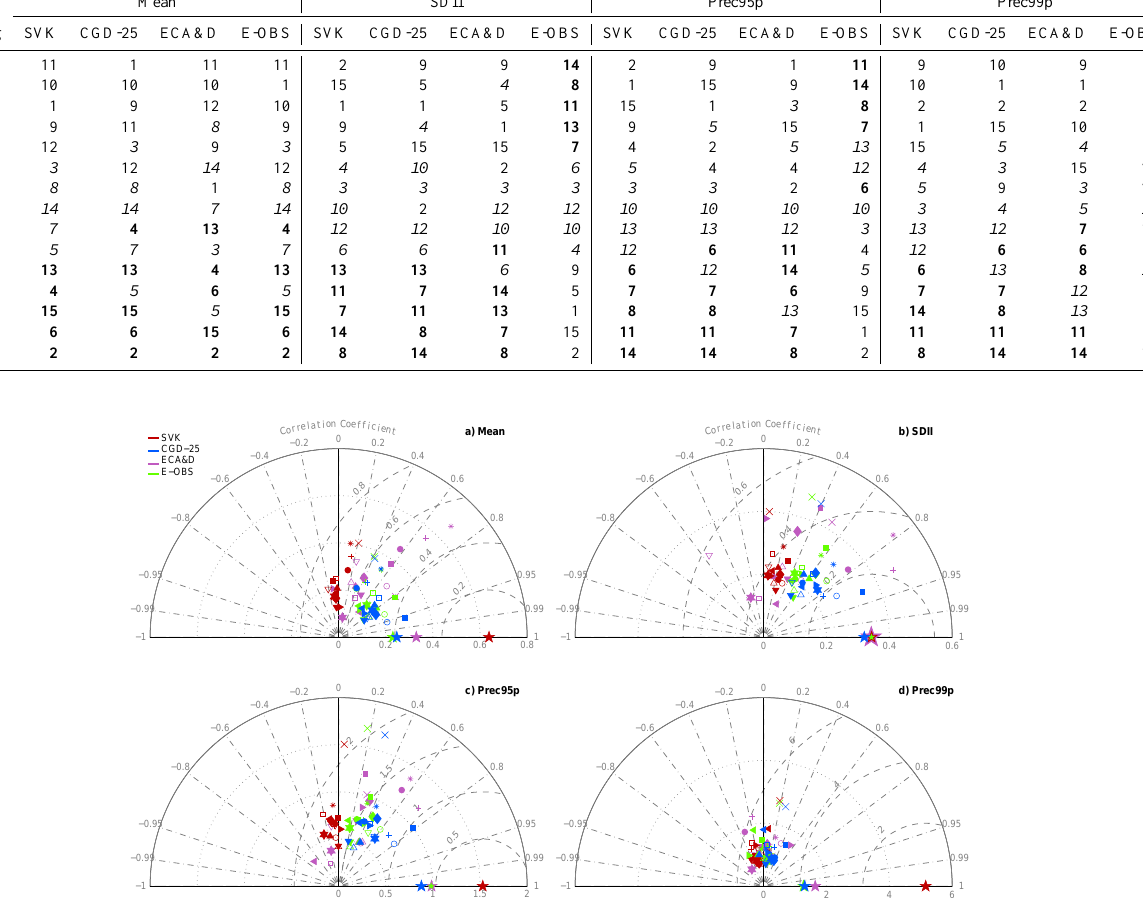
Table 2. Ranking of the RCMs depending on their bias for the observational data sets. Model numbers are shown in Table 1. The models highlighted in roman, italic and bold refer to the models with rank 1 to 5, 6 to 10 and 11 to 15 for SVK, respectively. Mean SDII Prec95p Prec99p